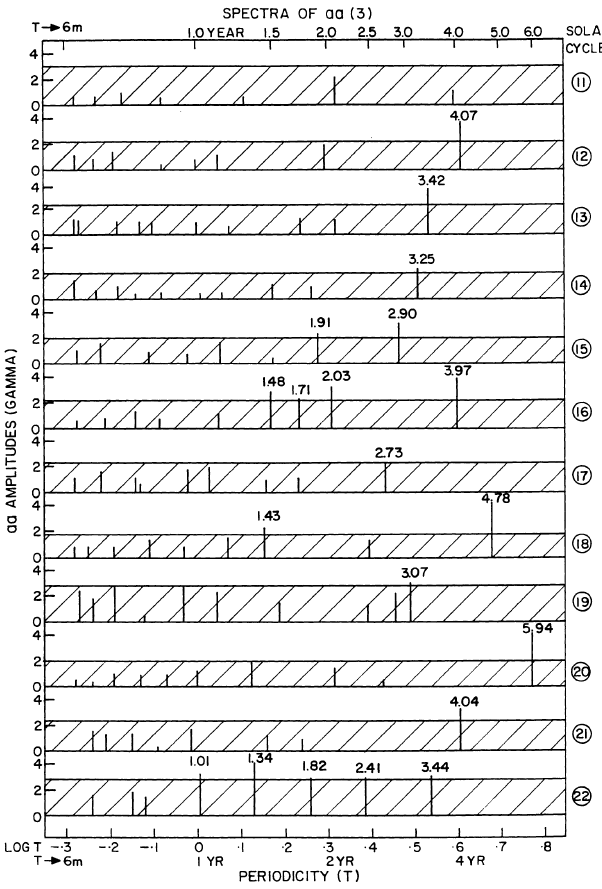
Fig. 6. Spectra for 3-monthly aa indices, (44 values in 11 y) separately for the solar cycles 11-22 . The hatched portions represent 2